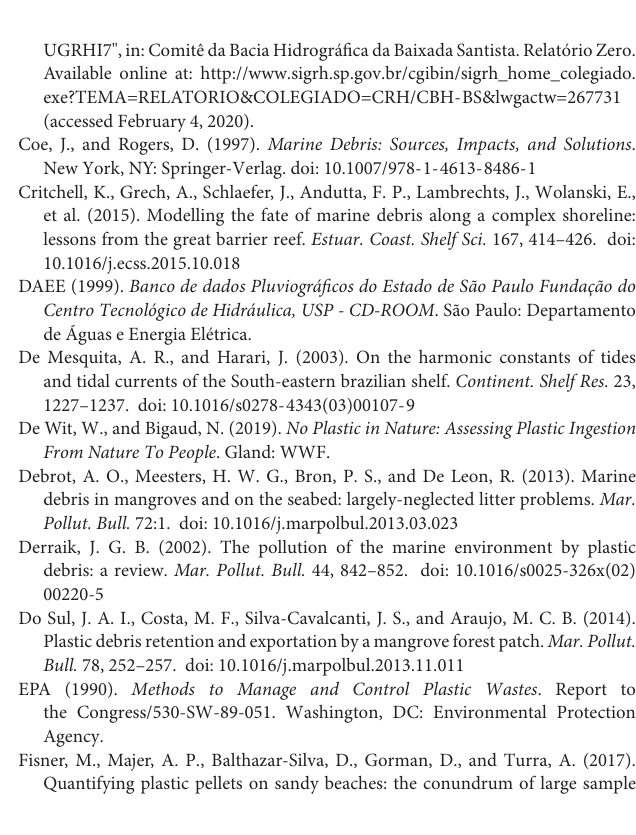
Supplementary Figure 1 | Relationship between monthly rainfall and modeled dispersal area (km 2 ) of microplastic pellets from three different release points within the estuary and open coastal waters of the Santos region. Correlations are Pearson’s correlation ( r ) and two-tailed probability ( P